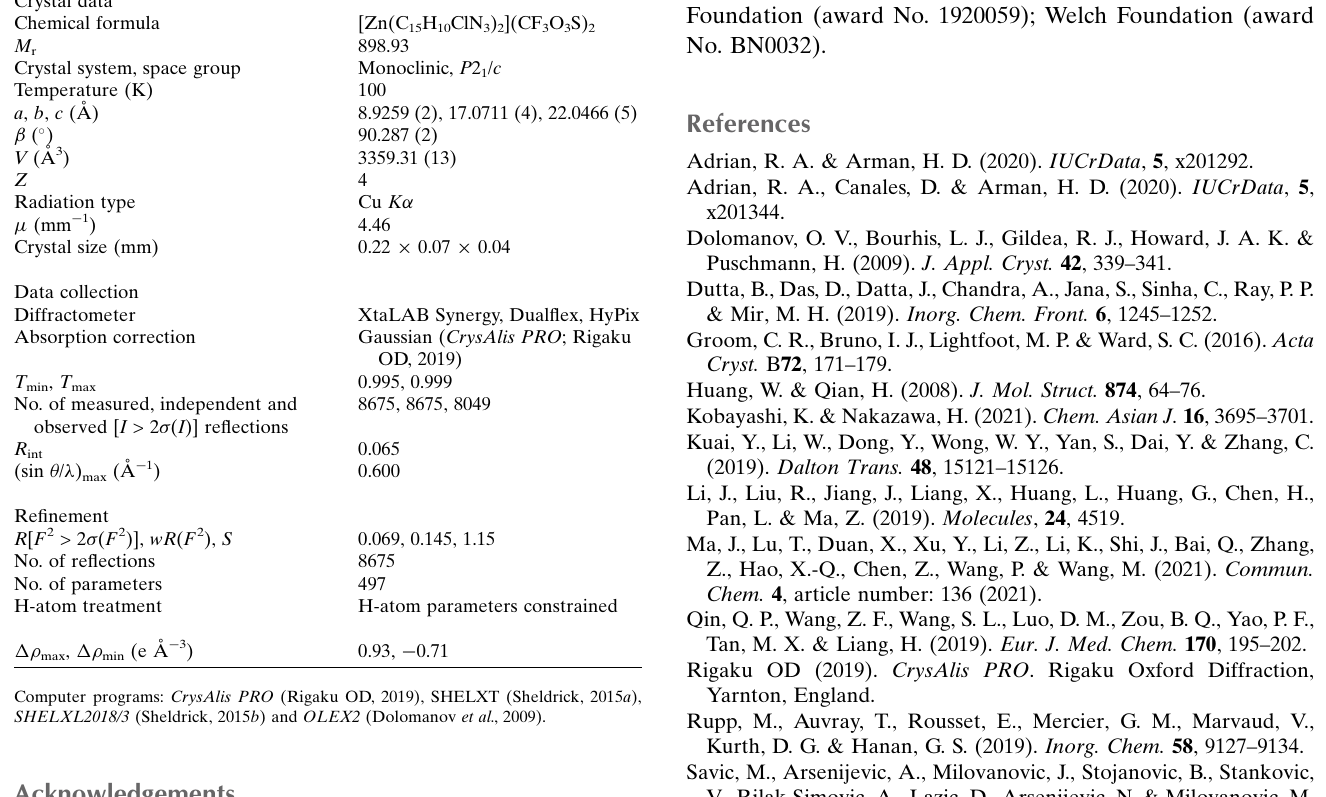
Table 2 Experimental details. Crystal data Chemical